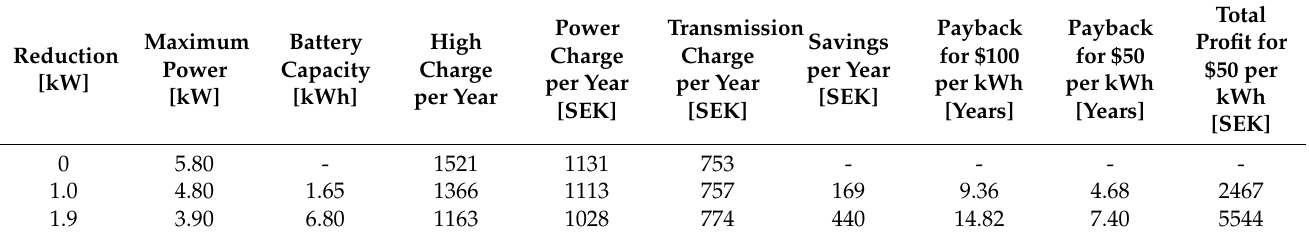
Table 5. Economic calculations before and after reduction of the power peak for low power houses.